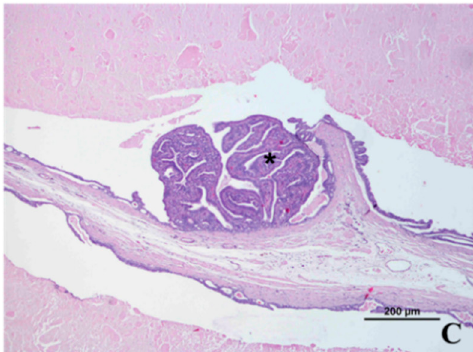
Figure 11. Microscopic appearance of abnormal rat seminal vesicles and prostate at 61 weeks of age in prostate cancer induced group. ( A ) Enlarged seminal vesicle showing corpora amylacea (*); ( B ) Dorsolateral left prostate lobe showing extensive necrosis, acute acini inflammation (*) and chronic stromal inflammation with fibrosis (arrow) (see normal dorsal and lateral prostate lobes in Figure 2B,F). ( C ) Seminal vesicle mural atrophy and presence of a papillary adenoma (*).